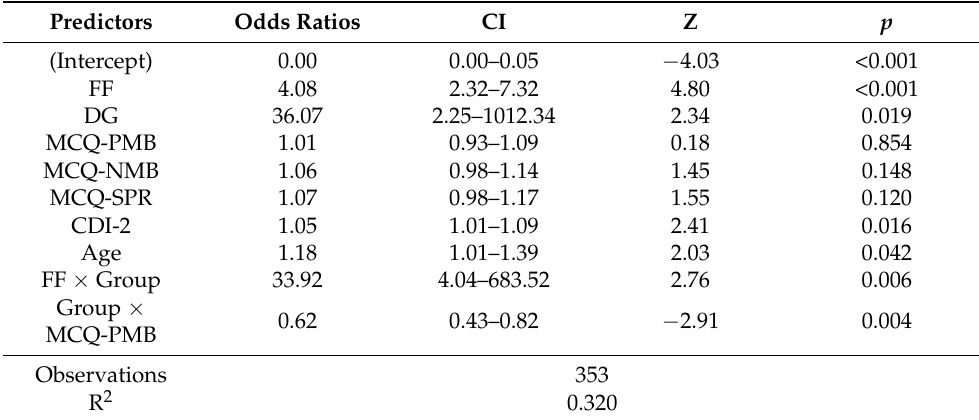
Table 3. Results of the multivariate logistic regression analysis on